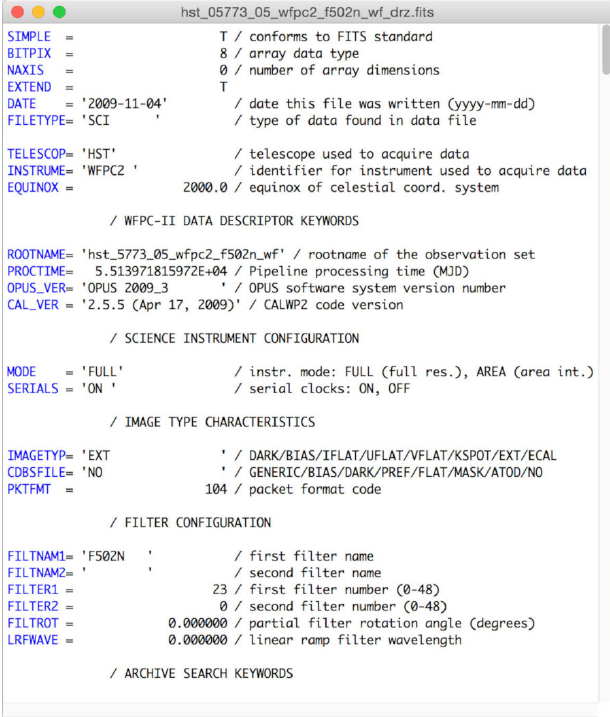
Fig. 38.— First header of the HST Eagle nebula image